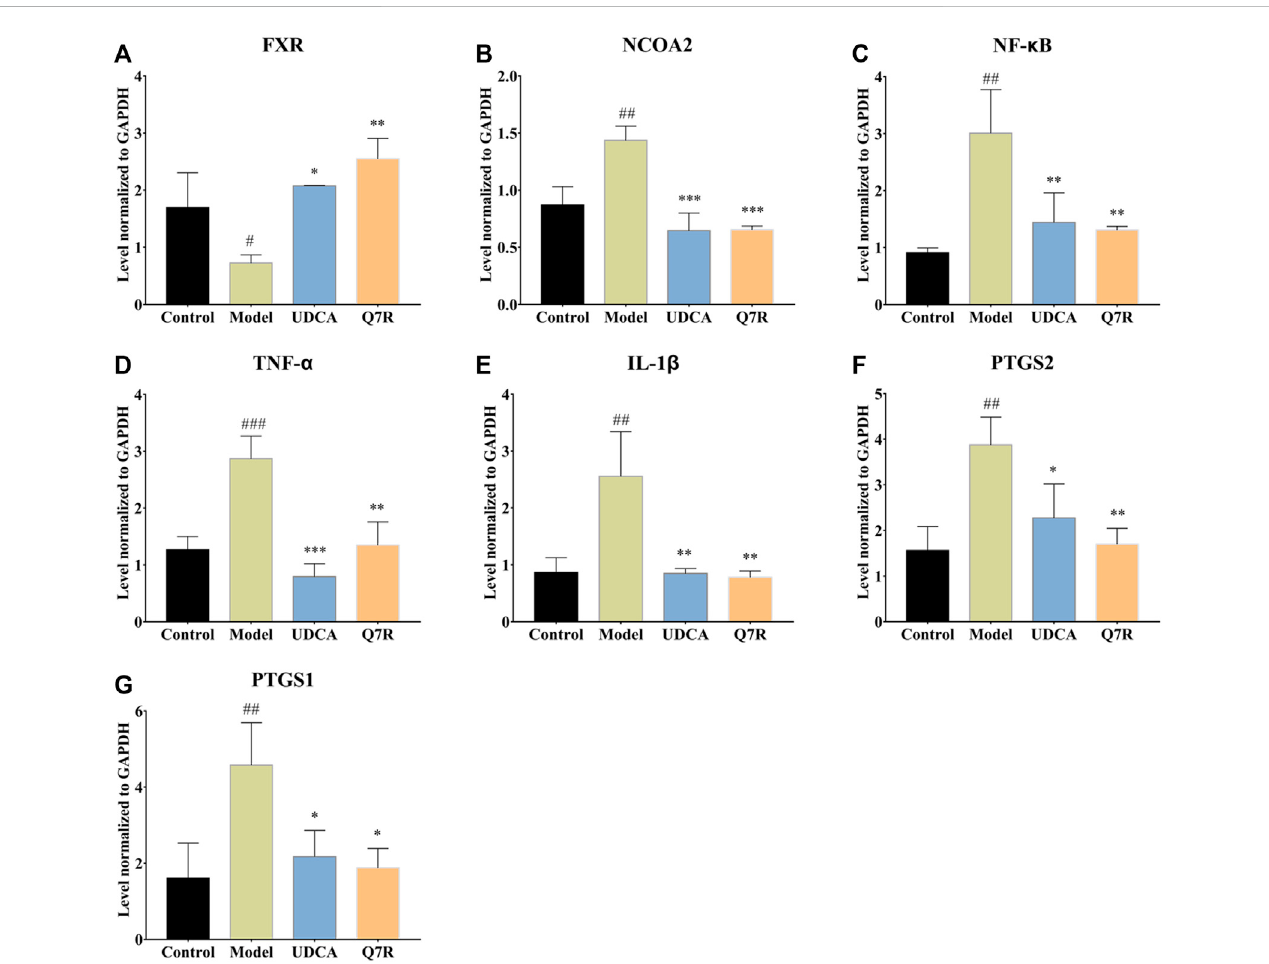
FIGURE 4 RT-PCR analysis for FXR, NCOA2, NF- κ B, TNF- α , IL-1 β , PTGS2, PTGS1 mRNA levels in the liver of model rats ( n = 3). (A) FXR; (B) NCOA2; (C) NF- κ B; (D) TNF- α ; (E) IL-1 β ; (F) PTGS2; (G) PTGS1; Values are presented as mean ± SEM for three biological replicates per group. * p < .05, ** p < .01, *** p < .005 vs.